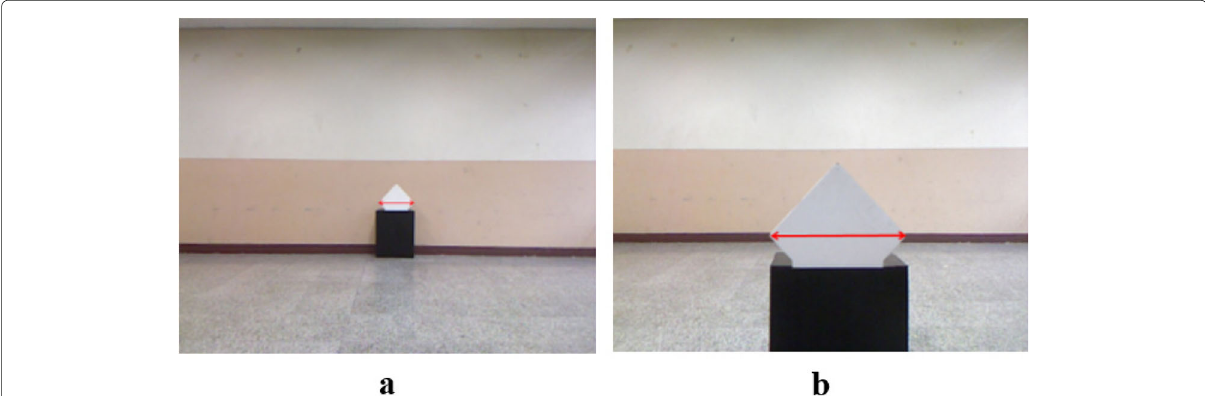
Fig. 1 Measurement of relationship between distance and width of object. a 4 m and b 1